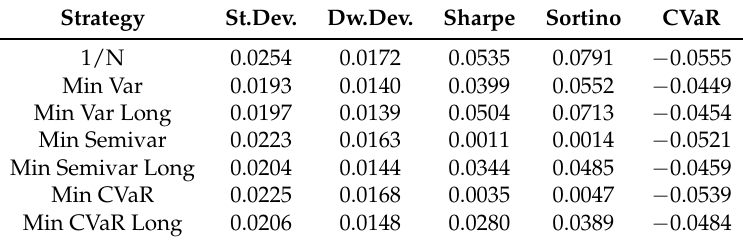
Table 3. 5 year rolling window estimation.